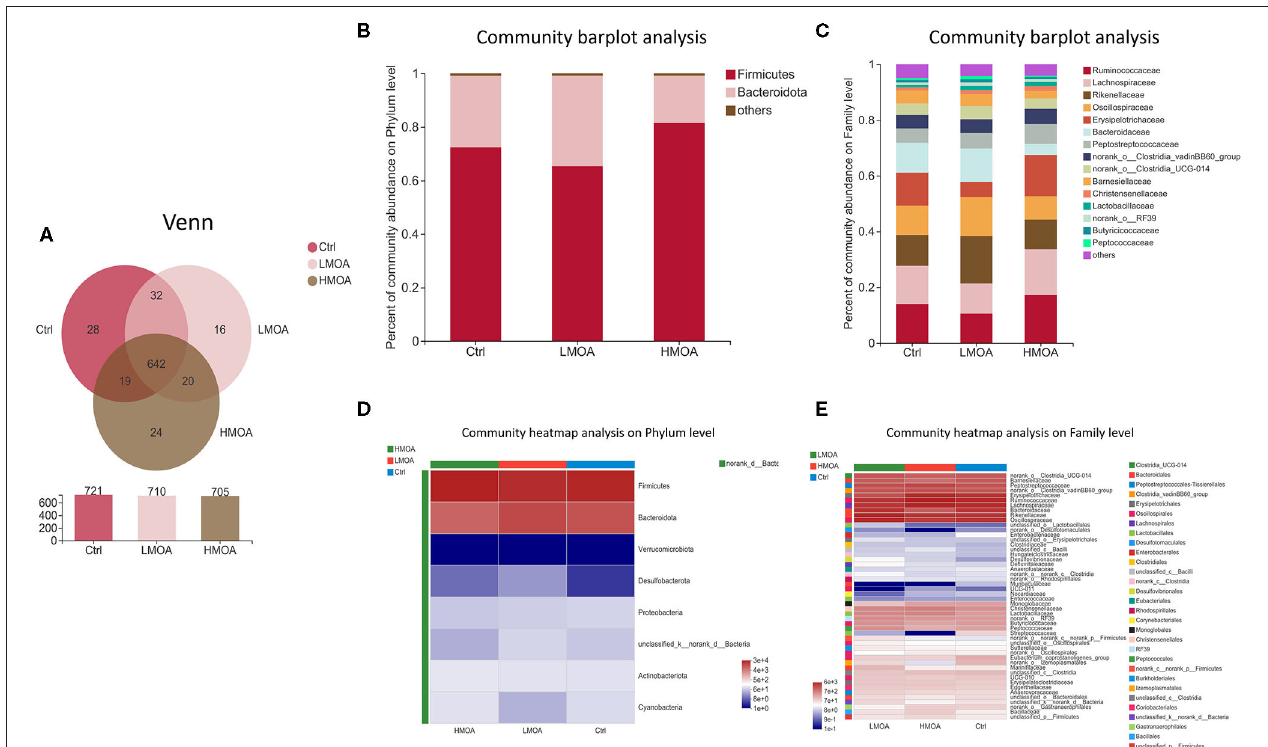
FIGURE 6 | The microbial community composition of cecal in 42-d broilers as affected by dietary MOA supplementation. (A) Venn diagrams of dietary treatments at the OTUs level. (B,C) Distribution of community barplot in cecum microorganism at the phylum and family level. (D,E) Heatmap of the cecum microorganism relative richness at the phylum and family level among dietary treatments. Ctrl: a basal diet of corn-soybean meal with 0 mg/kg of mixed organic acid; LMOA: a basal diet with 3,000 mg/kg of mixed organic acids; HMOA: a basal diet with 6,000 mg/kg of mixed organic acids. n =